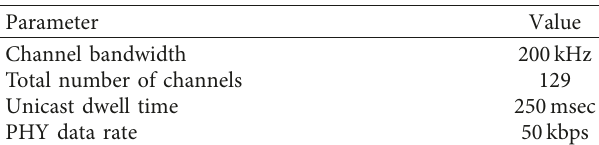
Table 1: System parameters.